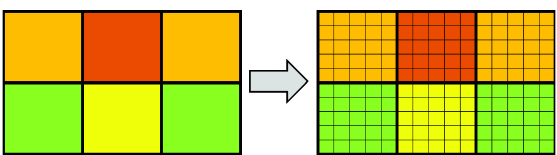
Figure 3. Illustration of the increase of solar radiation data resolution from 10 km × 10 km to 1 km × 1 km.